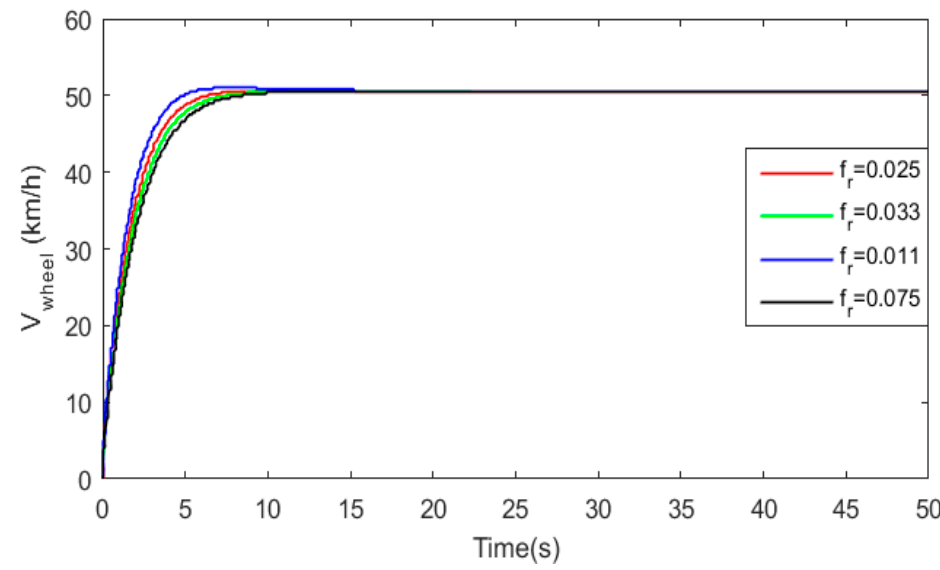
Figure 36. Effect of variation of surface-friction coefficient on BEV speed response.